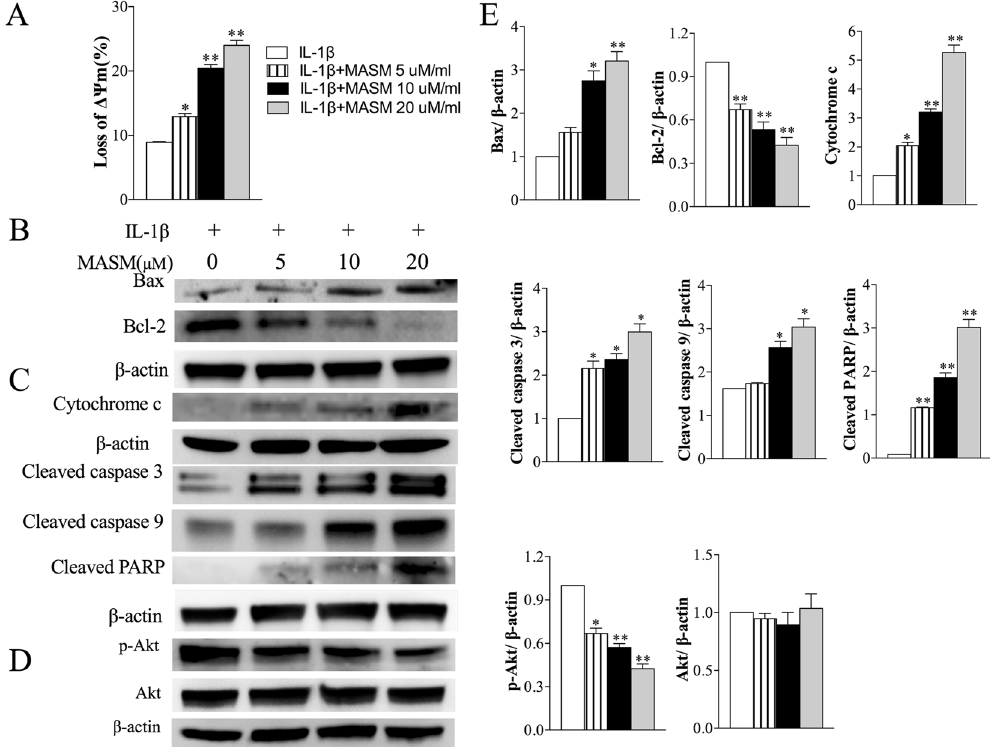
Figure 5. The effects of MASM on the expression of apoptosis-related factors in human RA-FLS. Cells were pretreated with different concentrations of MASM (0–20 μ M) for 1 h, and then 2 ng/ml IL-1 β was added for another co-stimulation of 48 hours. ( A ) After the indicated treatment, the mitochondrial membrane potential was measured by the JC-1 dye, the mean JC-1 fluorescence intensity was detected by FASC analysis. The quantification of the result is shown. ( B ) Western blot analysis of Bax, Bcl-2, Cytochrome C, Cleaved caspase 3, cleaved caspase 9 and Cleaved caspase PARP expression. ( C ) Western blot analysis p-Akt, Akt, ( D ) Band intensities was normalized to β -actin. Data are shown as the mean ± SEM (n = 3) from three independent experiments. * P < 0.05, ** P < 0.01, relative to control